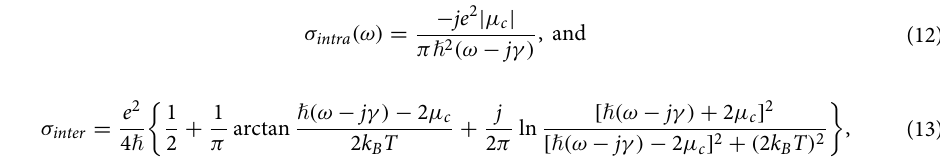
Figure 2. Graphene optical conductivity versus normalized angular frequency � = ℏ ω/ 2 µ µ ( o ) c = 0.35 eV ) for various chemical potential µ c : ( a ) real part and ( b ) imaginary part. The carrier relaxation time τ c = 0.03 ps and temperature of T = 300°